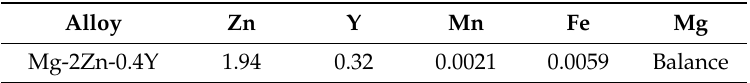
Table 1. Chemical composition of the Mg-2Zn-0.4Y alloy in wt.%.